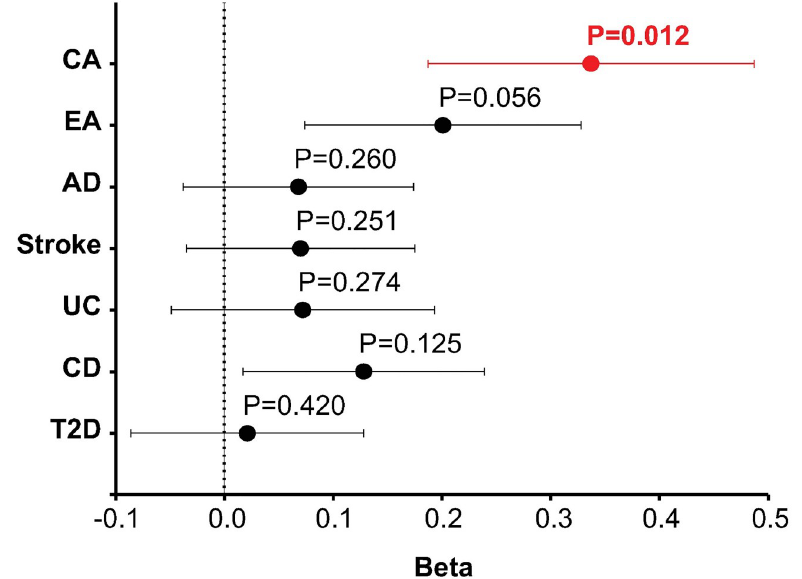
Fig 6. MAGMA GSA results for adult cortex SATB2 interactome using the summary statistics from multiple GWAS. GSA of SATB2 interactome in CA and EA plus post-hoc analysis of 2 brain-related disease and 3 non-brain diseases GWAS datasets. Phenotypes are listed on the y-axis (CA, Cognitive Ability; EA, Educational Attainment; AD, Alzheimer’s disease; UC, Ulcerative Colitis; CD, Cardiovascular Disease; T2D, Type II Diabetes). P-values are shown above each data point, which represent beta values (x-axis). Horizontal bars indicate error bars (SE). Data also supplied in S6 Table.